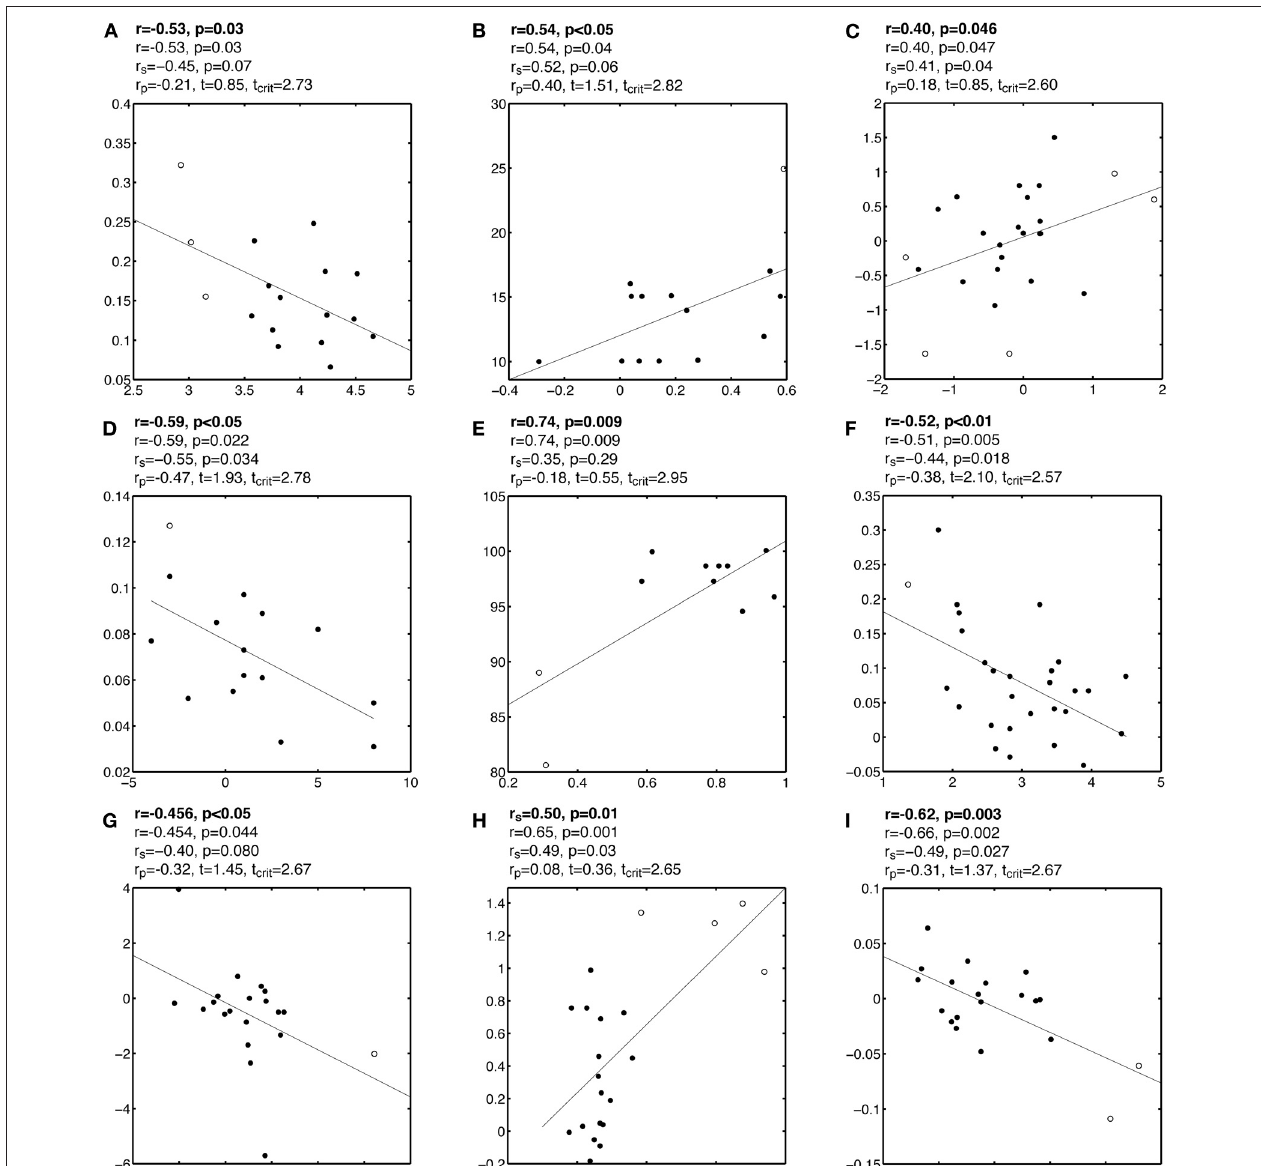
FIGURE A3 | Examples of false correlations potentially due to outliers. See Figure A1 caption for